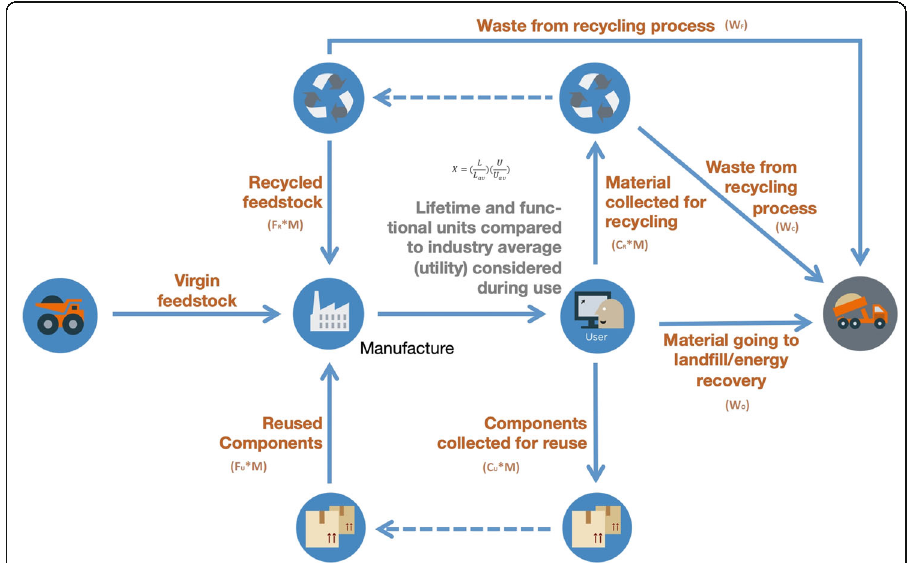
Fig. 1 Calculation of MCI (source: EM Foundation 2015 —